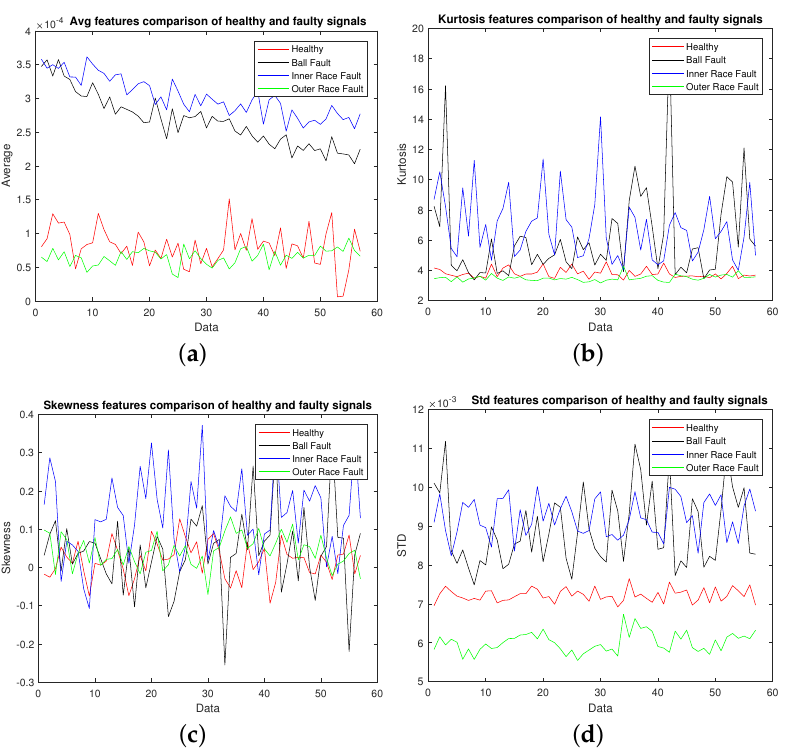
Figure 3. Statistical signal demonstration: ( a ) Average, ( b ) Kurtosis, ( c ) Skewness, ( d ) Standard Deviation.